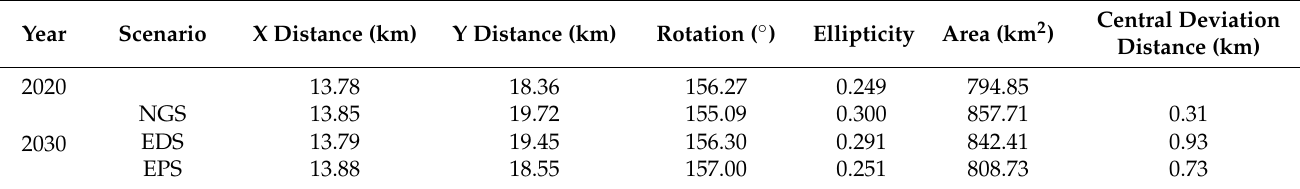
Figure 11. The standard deviational spatial distribution of construction land in 2020 and 2030. Table 5. Parameter values of standard deviational ellipse.